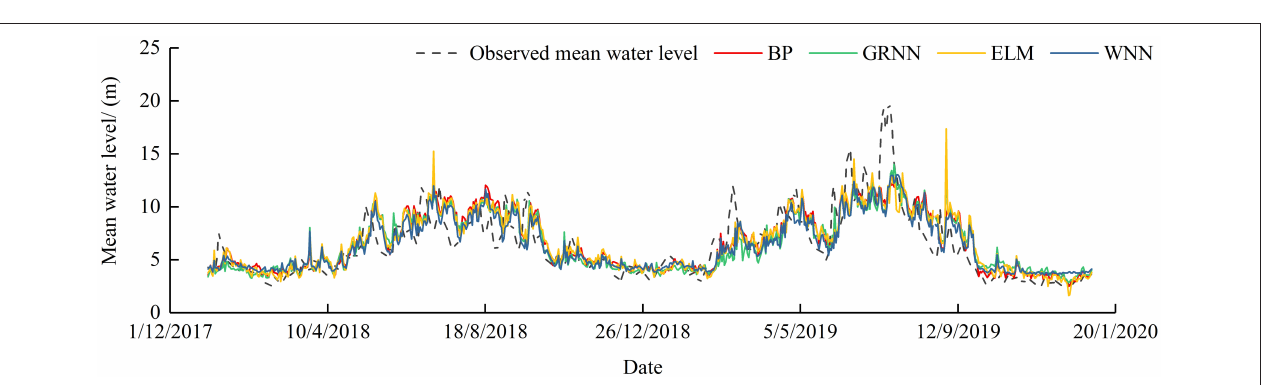
FIGURE 4 | Scatter plots of observed and simulated mean water level.